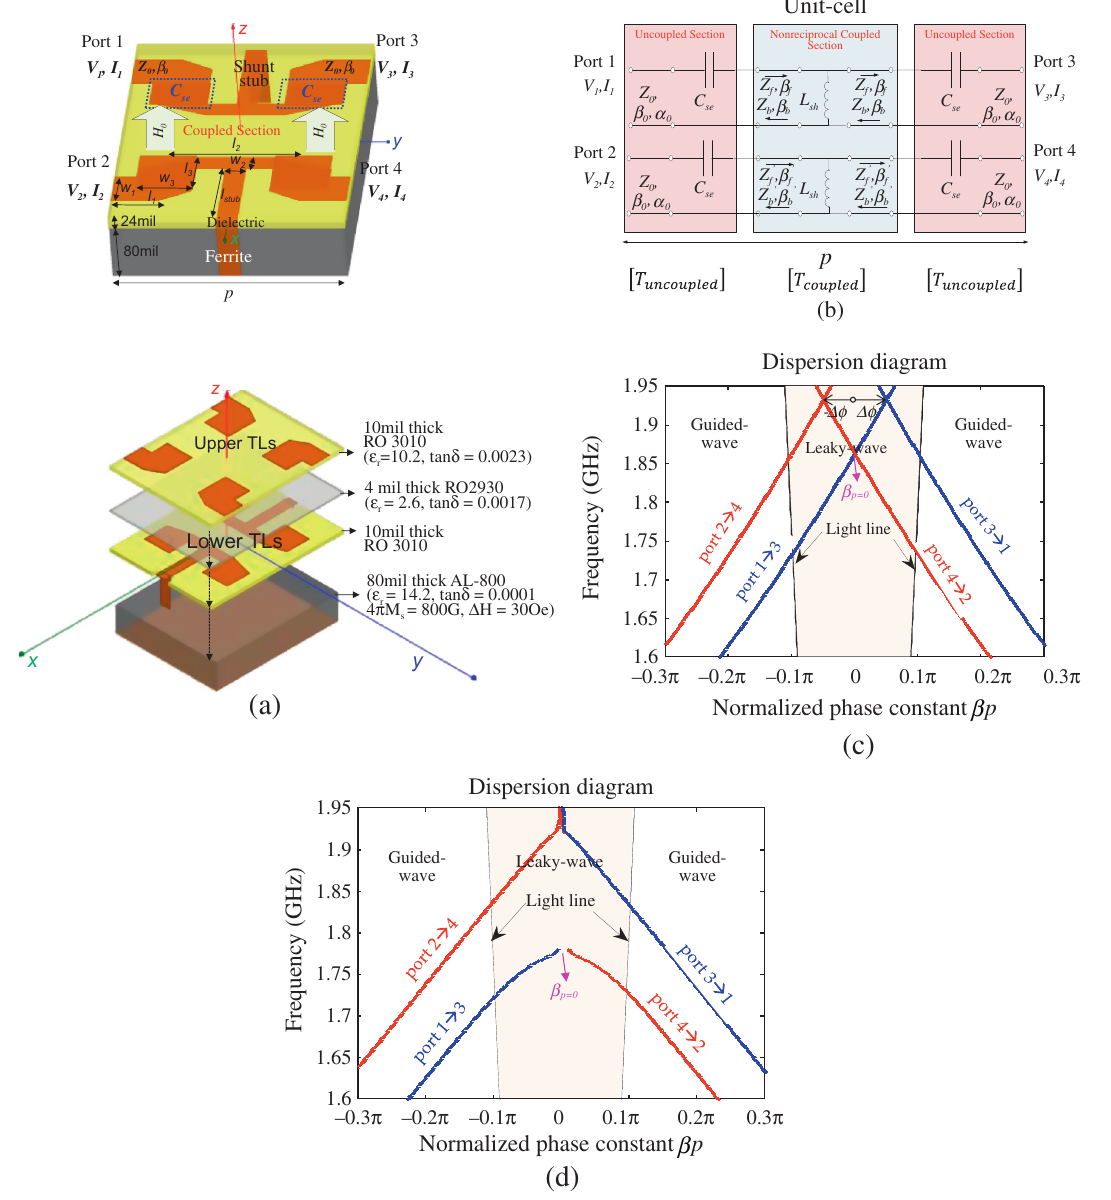
Figure 5. (a) Modified unit-cell geometry with series chip capacitors and shunt inductors to introduce low frequency resonance in the leaky- wave region of the K- x diagram. This approach allowed us to miniaturize the LWA design and to operate at L -band. Dimensions are: l 1 = 105, l 2 = 120, w 1 = 60, w 2 = 30, w 3 = 80, l 3 = 75, l stub = 131.5 (mils), and (b) its equivalent circuit model as a cascade of uncoupled and coupled sections to analytically calculate the unit-cell T -matrix. (c) Dispersion curves when coupling between the lines ( L m = 10 (cid:2) 3 pH, C m = 10 (cid:2) 3 pF) is negligible and (d) when L m = 5.45 nH, C m = 1.15